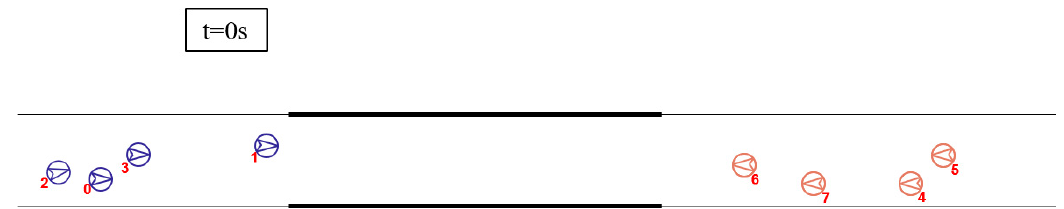
Figure 16. Evacuation scene setting of opposite pedestrian